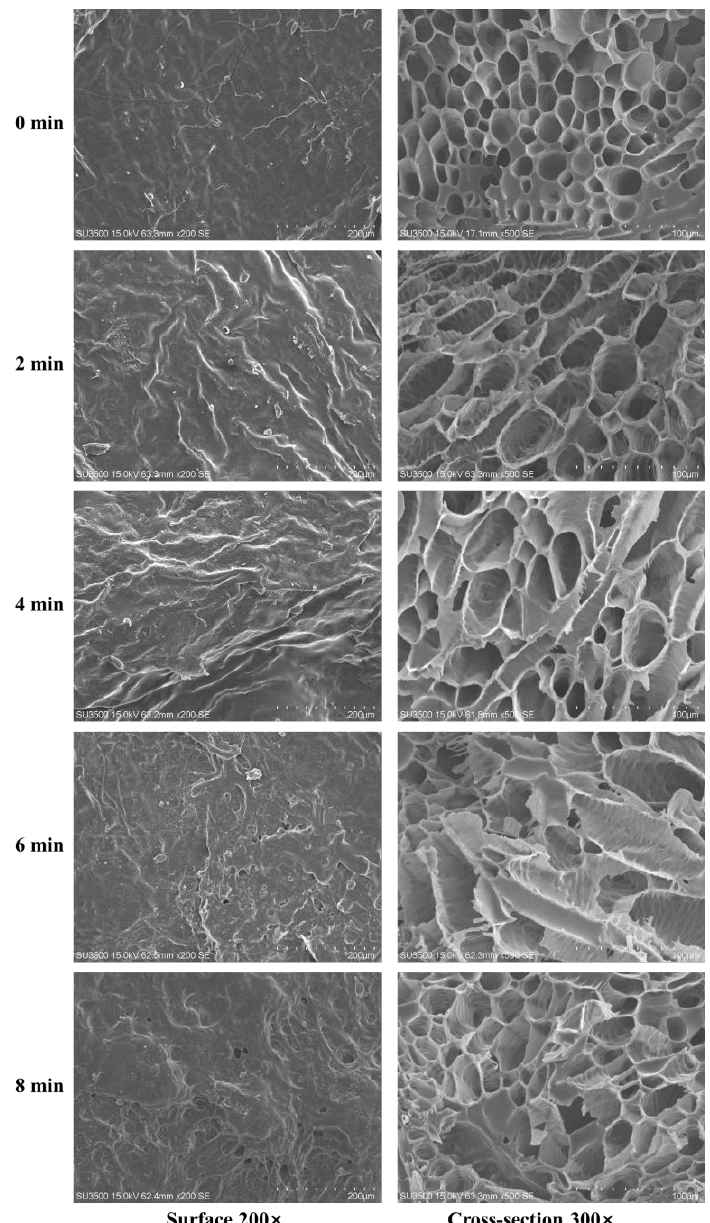
Figure 5. Scanning electron microscope images of A. sessiliflorus fruits with different blanching treatments. The magnification level is ×200 for the surface and ×300 for the cross-section.